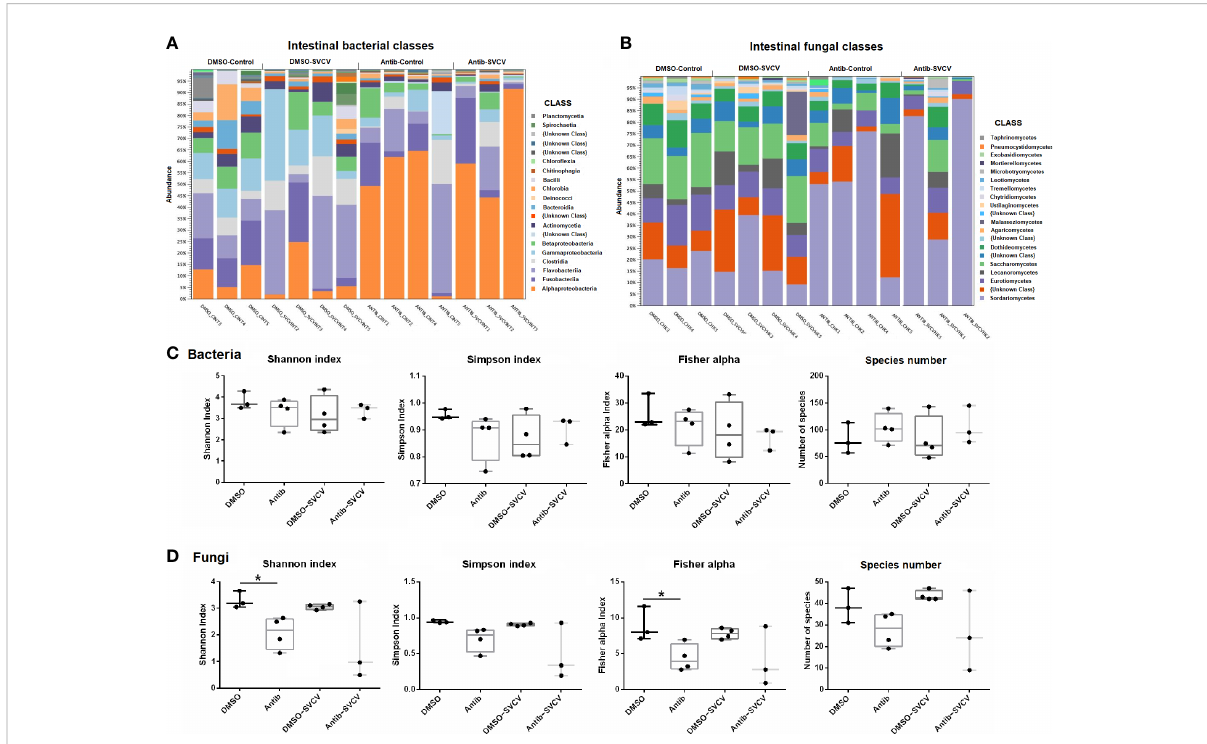
FIGURE 2 Taxa relative abundances in the intestine of zebra fi sh treated with DMSO (vehicle) or SMX+CLA under SVCV-infected and uninfected conditions. (A) Relative abundance of the main bacterial classes. (B) Relative abundance of the main fungal classes. (C) Shannon entropy, Simpson, Fisher alpha and species number indices of (C) bacteria and (D) fungi in the intestine of the experimental groups. Statistically signi fi cant differences are displayed as * (p<0.05) after the Mann − Whitney U